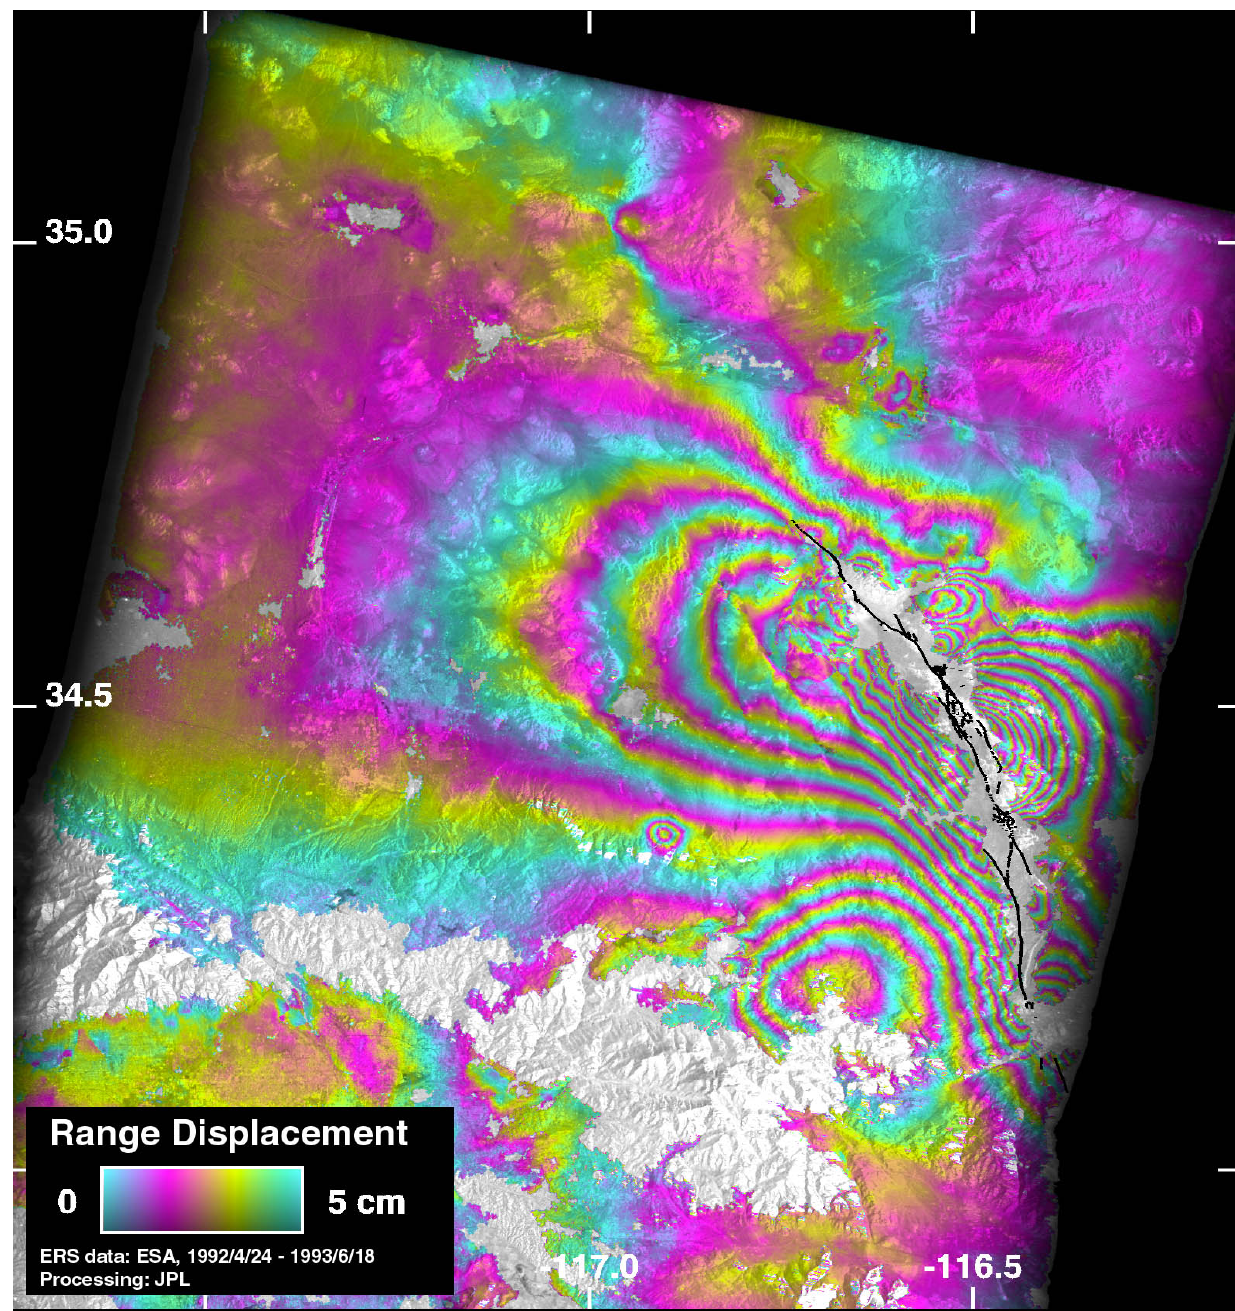
Figure 4. Observed co-seismic interferogram for the Landers earthquake (M = 7.3, 28 June 1992, CA, USA). One full color cycle represents here 5 cm of range displacement. Solid lines depict the fault geometry as mapped in the field. Gray areas are zones of low phase coherence that have been masked before phase unwrapping